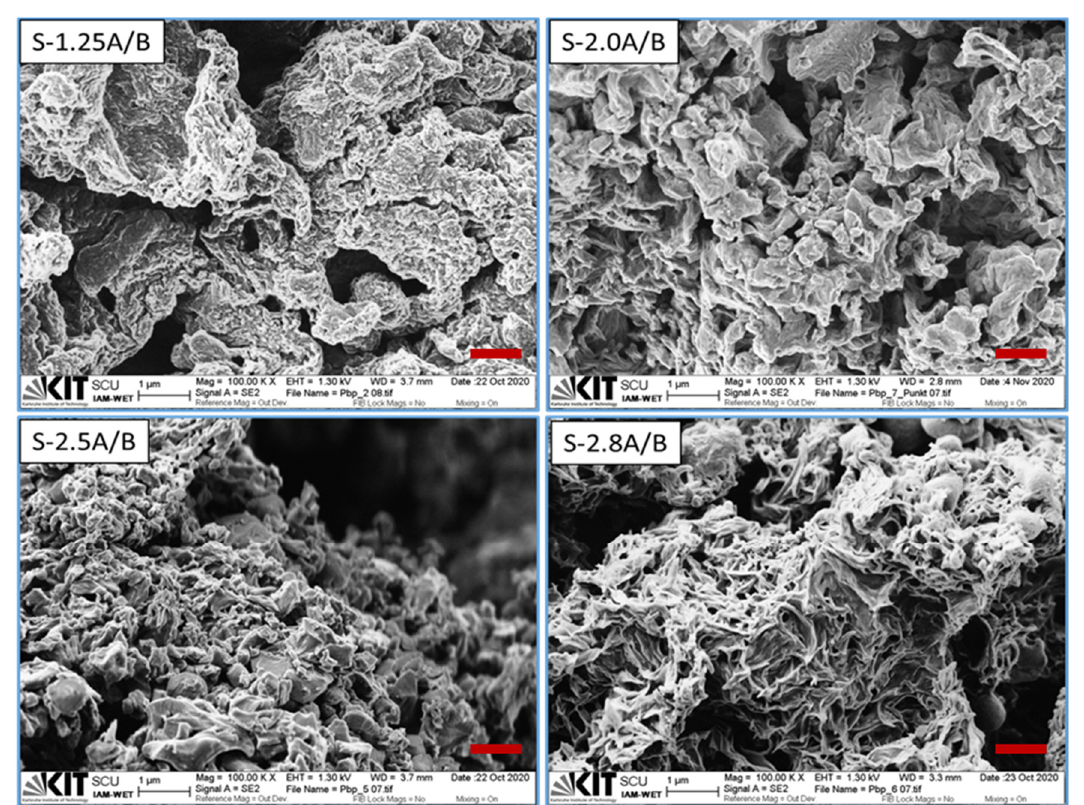
Figure 2. SEM of Pbp samples with various APS/BP = 1.25 to 2.8 mole ratio (0.1 M H 2 SO 4 , 1.0 mL DBSA). The red bars in the lower left half of each image correspond to 1 μ m.